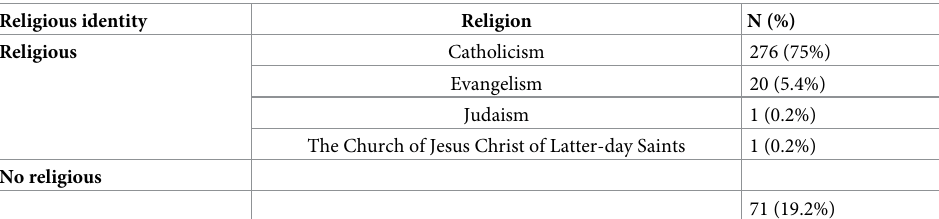
Table 2. Religious identity